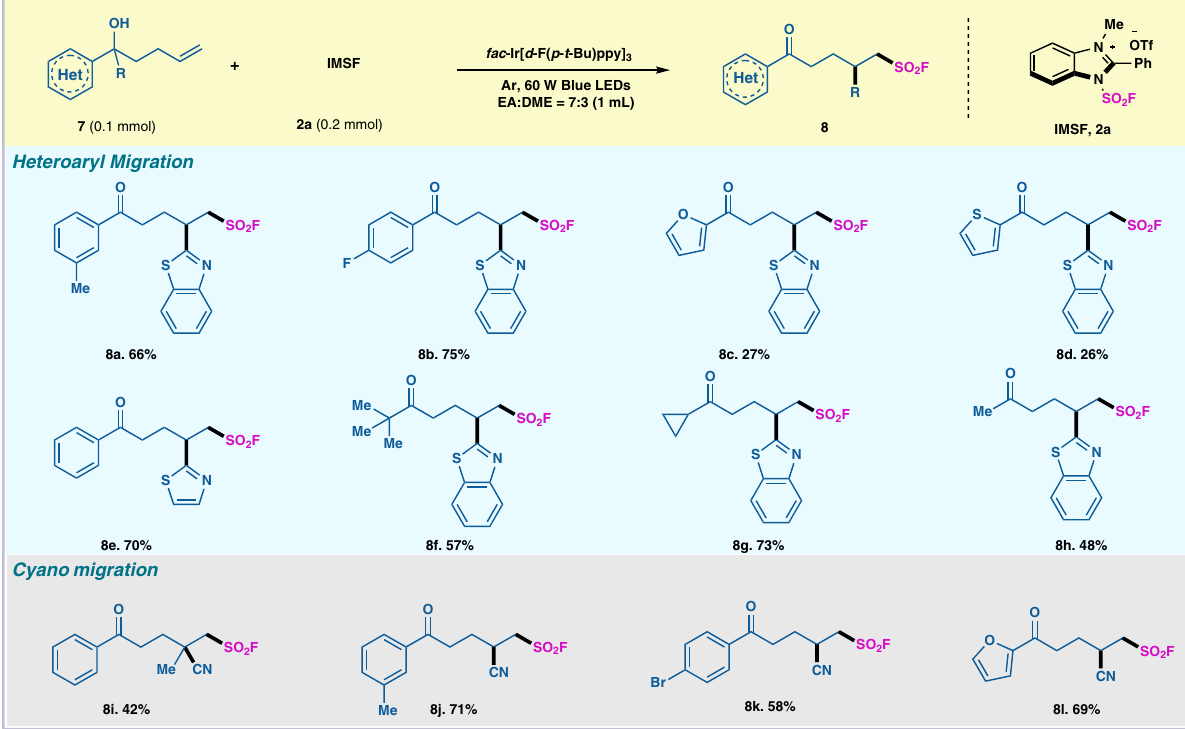
Fig. 4 Substrate scope of radical migration fl uorosulfonylation. All reactions were carried out with alkenes 7 (0.10 mmol), IMSF salt 2a (0.20 mmol, 2.0 equiv.), fac -Ir[ d -F( p - t -Bu)ppy] 3 (2 mol%) in DME:EA = 4:1 (1.0 mL) under Ar and 60 W blue LEDs about 12